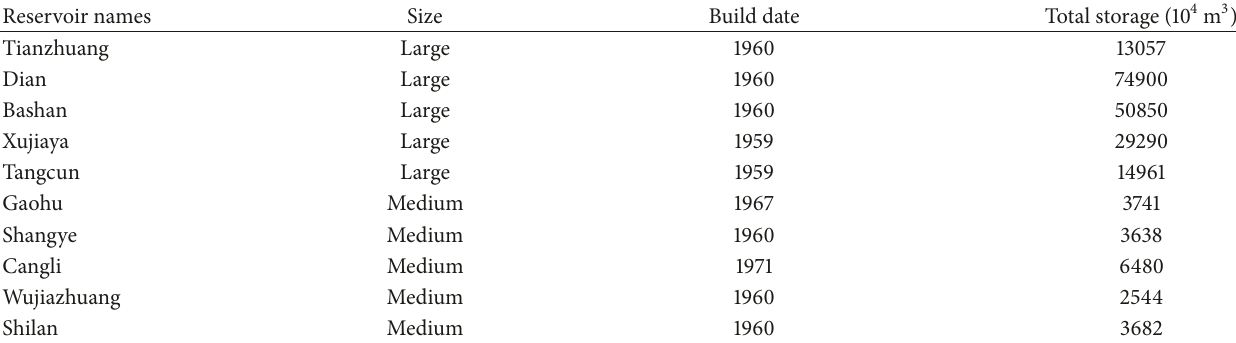
Table 3: Summary of large and medium sized reservoirs in Yi River